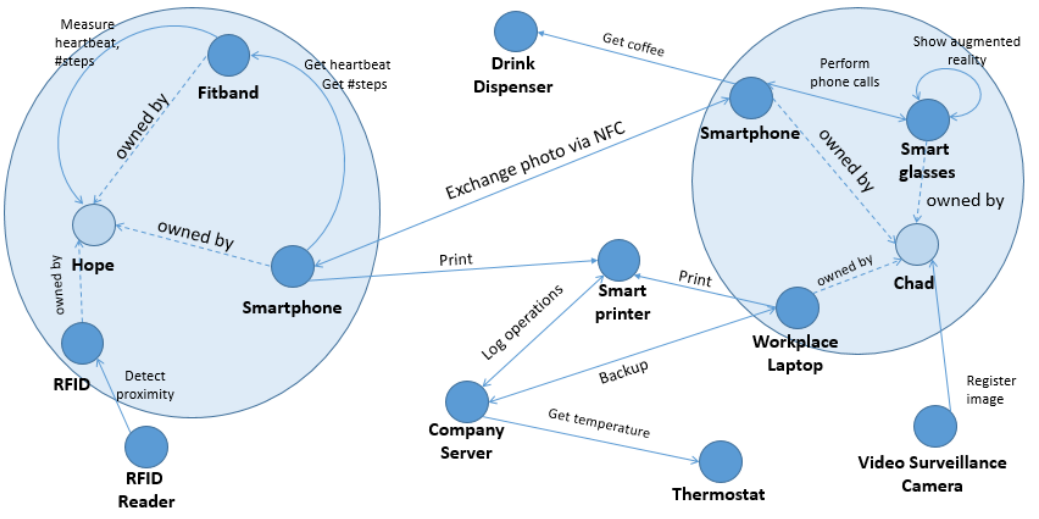
Figure 2. A representation of H2O Network with entity